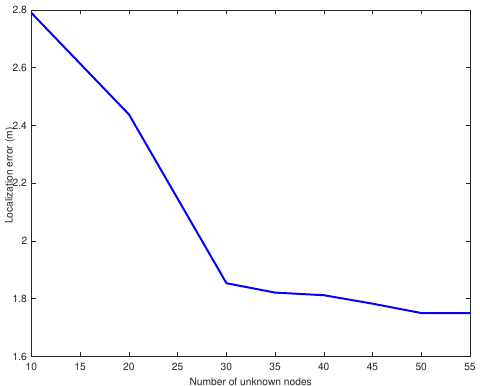
Figure 3. The localization error using 10 anchors with the varying number of unknown nodes in 400 m 2 applying Adam for sigma shadowing = 2.